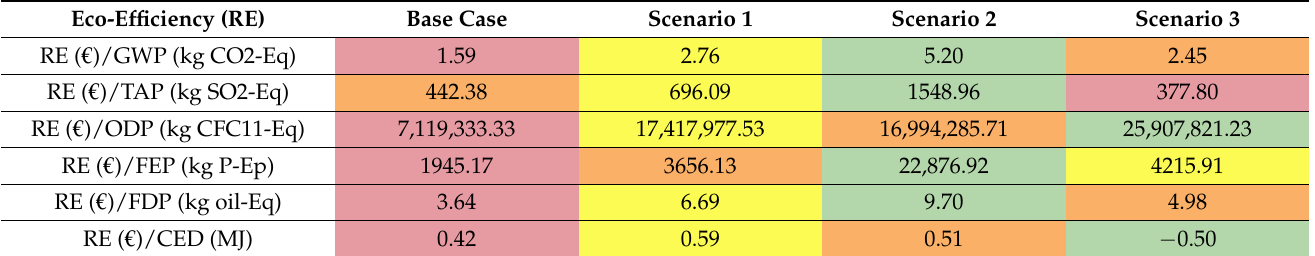
Table 7. Ranking of eco-efficiency (revenue) performance of the different scenarios in the different impact categories (green = best to red =